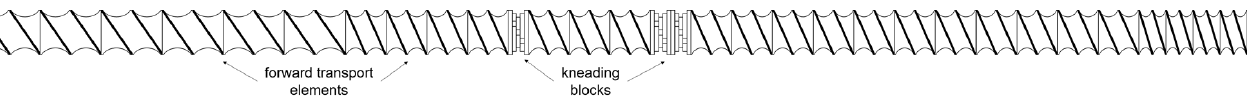
Figure 1. Illustration of the screw configuration in the extrusion